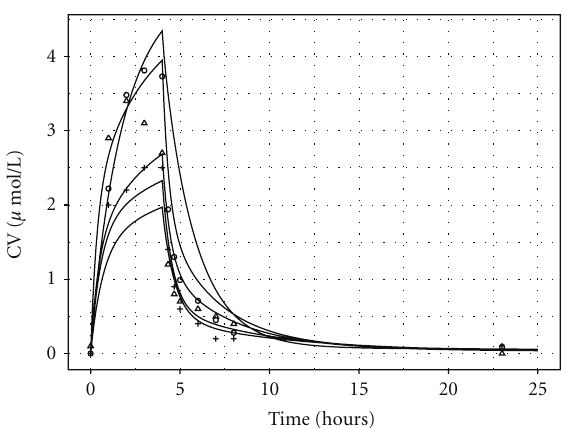
Figure 5: A comparison of 5 CV biomarker profiles corresponding to parameter sets sampled from the priors and reliable CV meas-